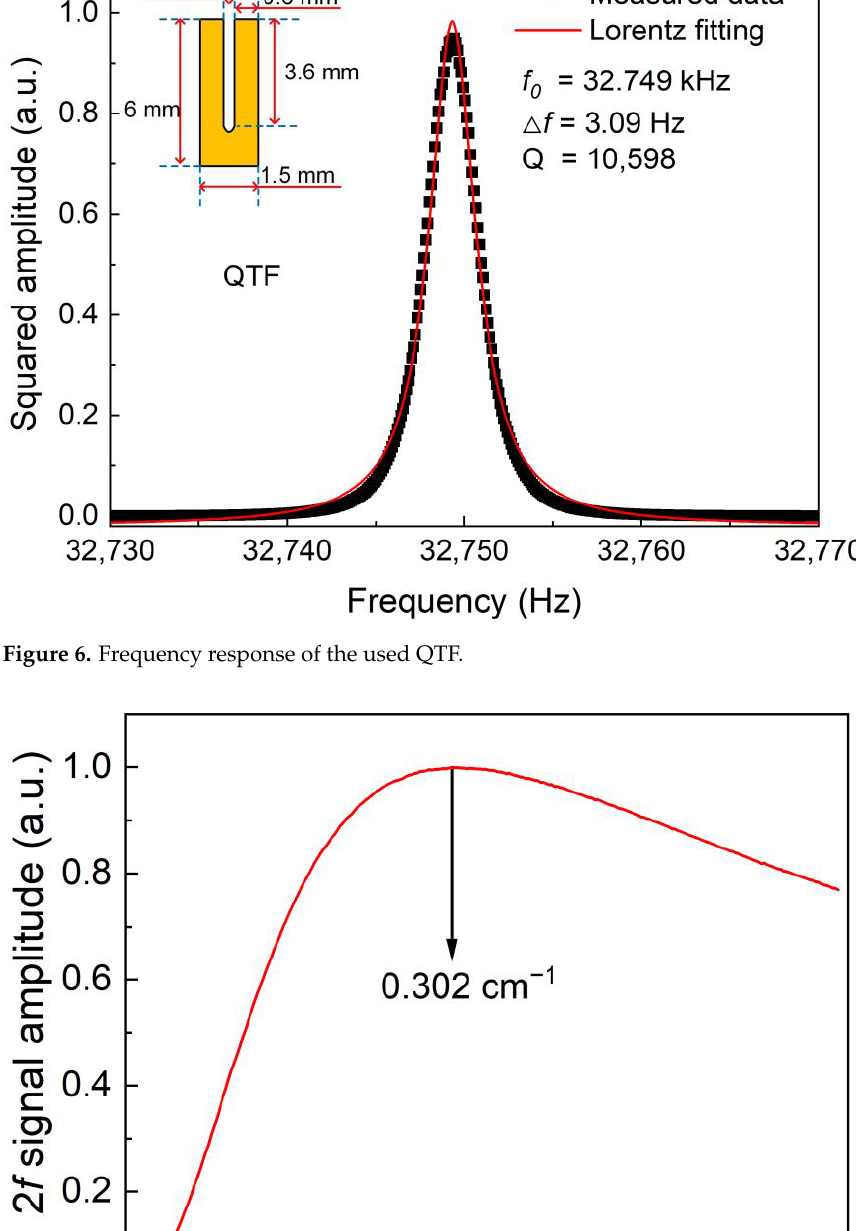
Figure 6. Frequency response of the used QTF.